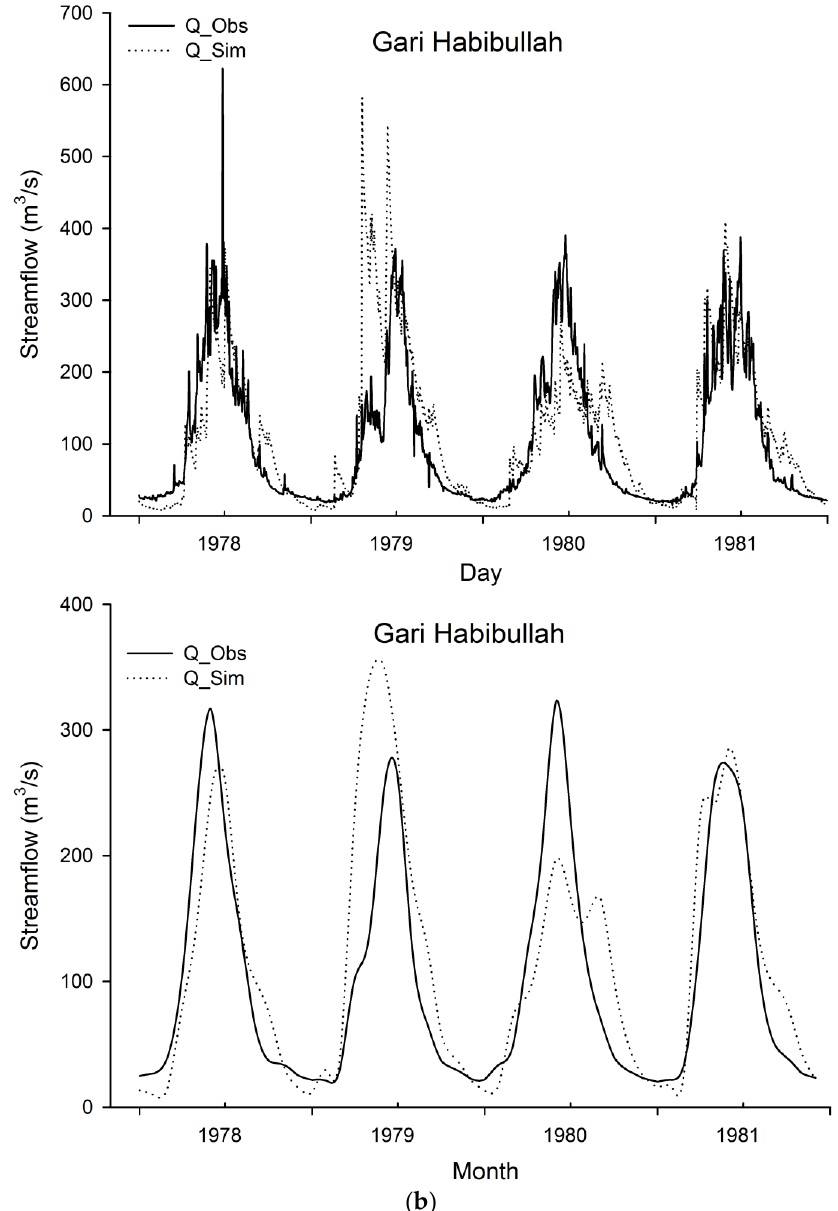
Figure 7. Comparison of daily and monthly observed and simulated streamflow at ( a ) Naran and ( b ) Gari Habibullah for validation (1978 ‒ 1981) in the Kunhar River basin.